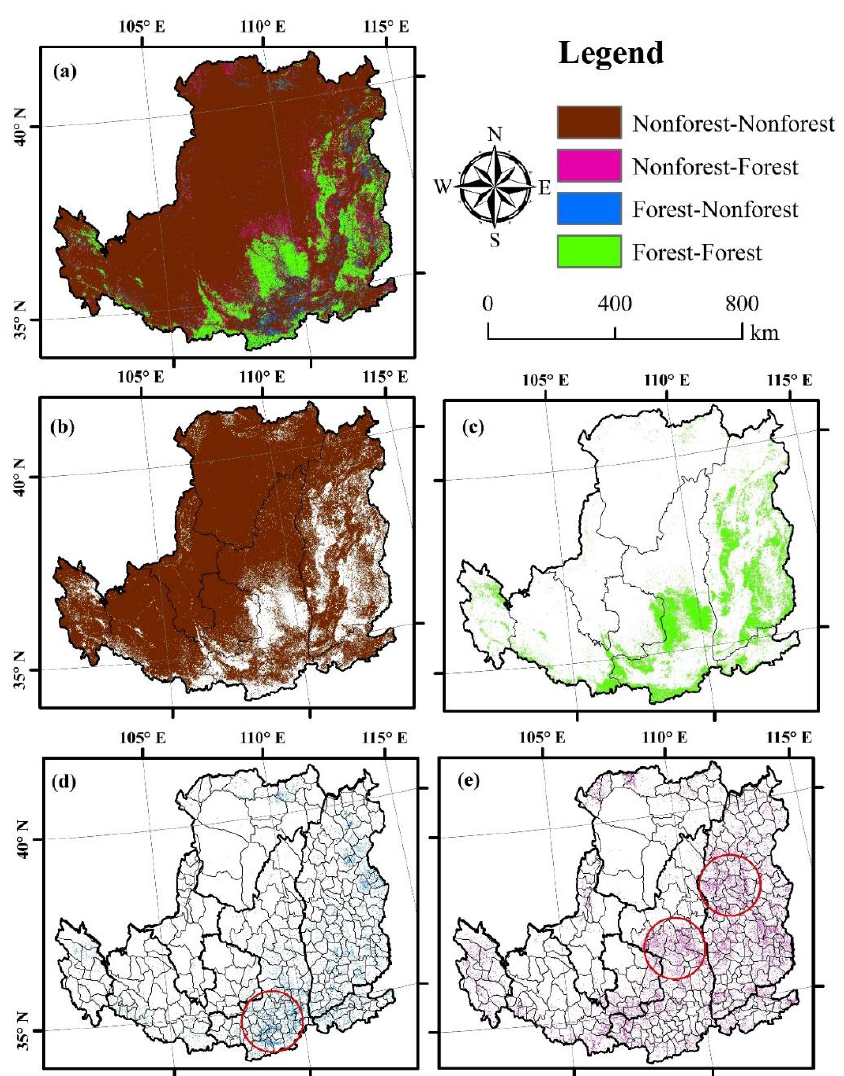
Figure 13. Spatial pattern of forest changes in the Loess Plateau ( a ). Unchanged areas of Loess Plateau including unchanged non-forest area ( b ) and unchanged forest area ( c ). The forest changes including conversion from forests to non-forest (deforestation) ( d ) and conversion from non-forest to forests (afforestation) ( e ).